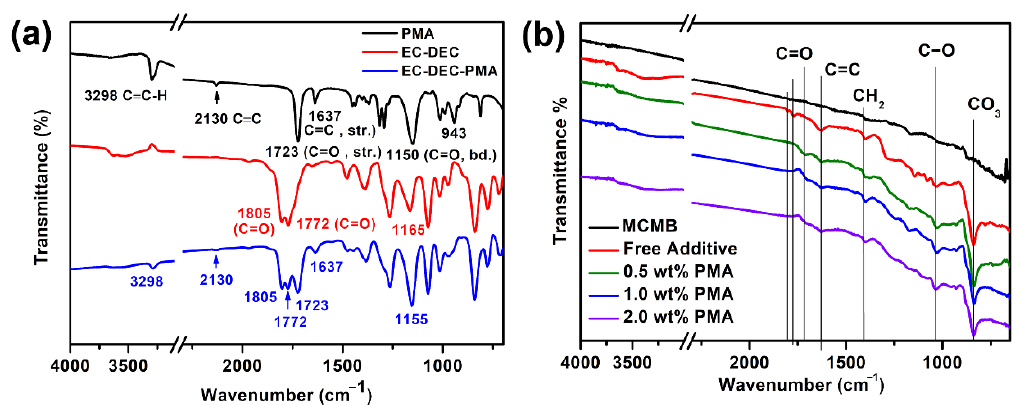
Figure 2. ( a ) ATR FT-IR spectra of PMA, EC/DEC electrolyte and EC/DEC containing PMA, and ( b ) ATR FT-IR spectra of fresh MCMB electrode and cycled MCMB electrode in the base electrolyte containing different PMA concentrations.